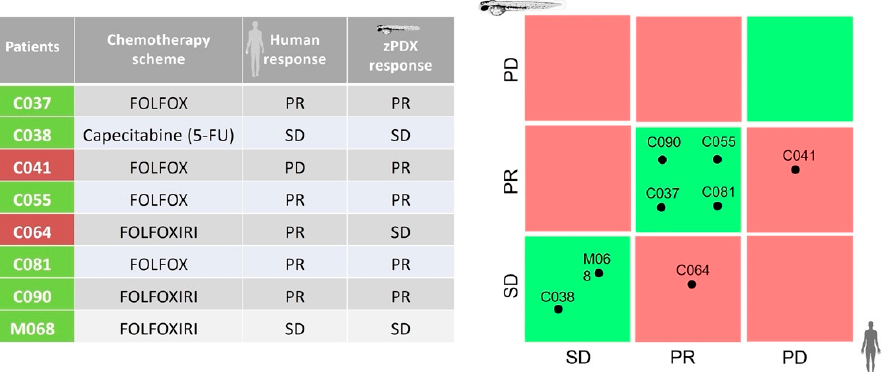
Figure 6. Comparison of the follow-up data with the predicting outcome of the zPDX. PR: partial response, SD: stable disease; PD: progression disease. Capecitabine was orally administered to Patient C038, whereas 5-FU was tested in its zPDX.